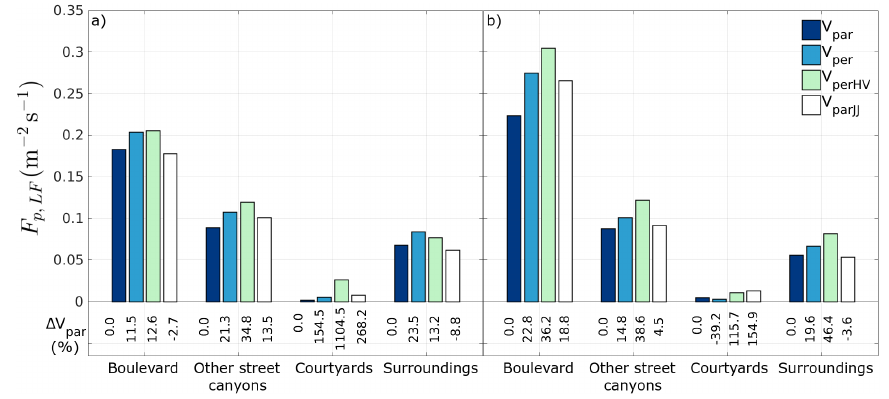
Figure A3. Horizontal mean of the low-frequency vertical turbulent particle flux density F p , LF (m − 2 s − 1 ) for the ( a ) neutral and ( b ) stable runs separately for the boulevard, other street canyons, courtyards and surroundings at z = 20 m for all runs. The difference to the value in V par is given in percentages ( ∆ V par ). Appendix E. Column-Averaged Dilution Rate (cid:104) D ( x , y ) (cid:105) t , z for the Supportive Simulations